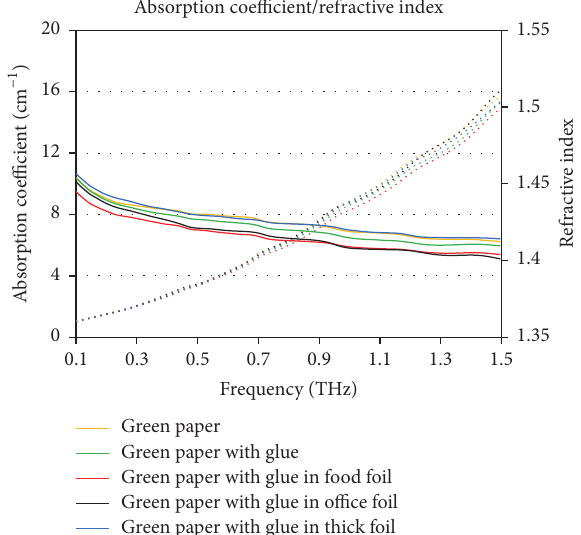
Figure 1: Absorption coefficient (dotted lines) and refractive index (full lines) curves for green paper with different additions.